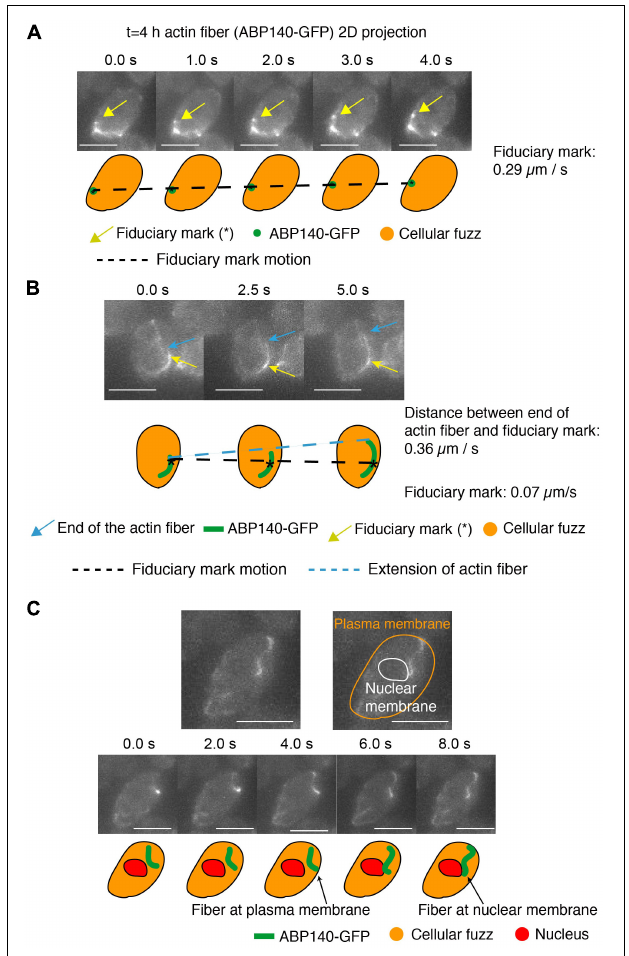
FIGURE 4 | Actin fibers in meiotic prophase undergo movement and treadmilling at meiotic prophase ( t = 4 h). (A–C) 2D projected images of actin fibers labeled by ABP140-GFP (green) plus the entire cellular region as defined by non-specifically bound GFP signal (orange). In (A,B) , a local intensity comprising a fiduciary mark is indicated by a gold arrow. In (B) , one end of an elongating actin fiber is indicated by a blue arrow. In (C) , the periphery of the nucleus, and thus the nuclear membrane, is defined by absence of cellular “fuzz.” Cartoons of these features are shown below. In (A) , the fiduciary mark moves 1.16 µ m during the interval from 0 to 4 s (0.29 µ m/s). In (B) The length between the fiduciary mark and the end of the actin fiber extends 1.82 µ m from 0 to 5 s (0.36 µ m/s) and the fiduciary mark is essentially immobile (position change of 0.07 µ m/s). (C) The actin fiber movement from the plasma membrane to the nuclear envelope, which is the dark region (red). Scale bar is 5 µ